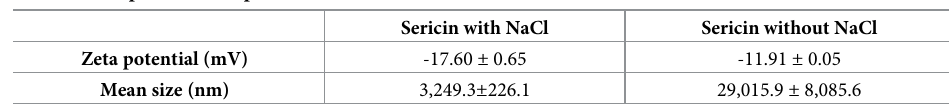
Table 1. Zeta potential and particle size of